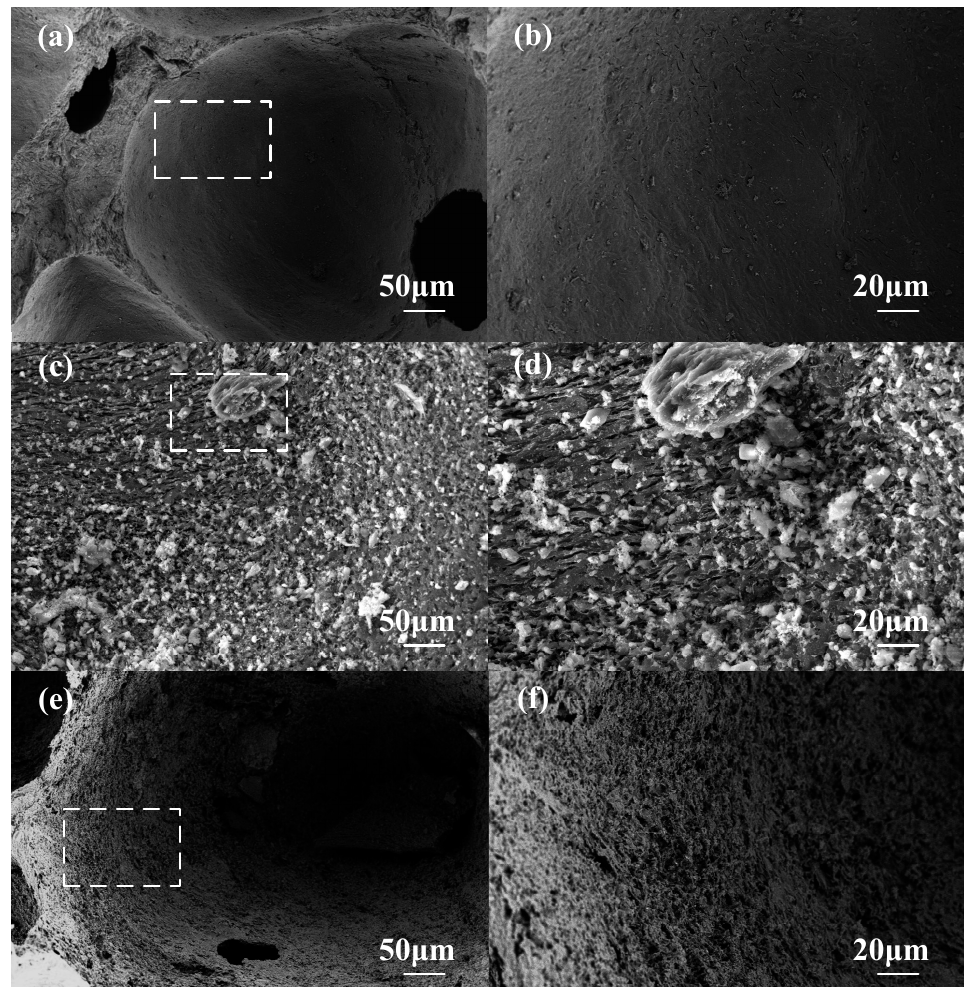
Figure 6. SEM images of pore wall surface: ( a ) low magnification of A-2-1, 5.24% weight loss; ( b ) high magnification of A-2-1, 5.24% weight loss; ( c ) low magnification of A-3-3, 9.39% weight loss; ( d ) high magnification of A-3-3, 9.39% weight loss; ( e ) low magnification of A-4-3, 14.56% weight loss; ( f ) high magnification of A-4-3, 14.56% weight loss.